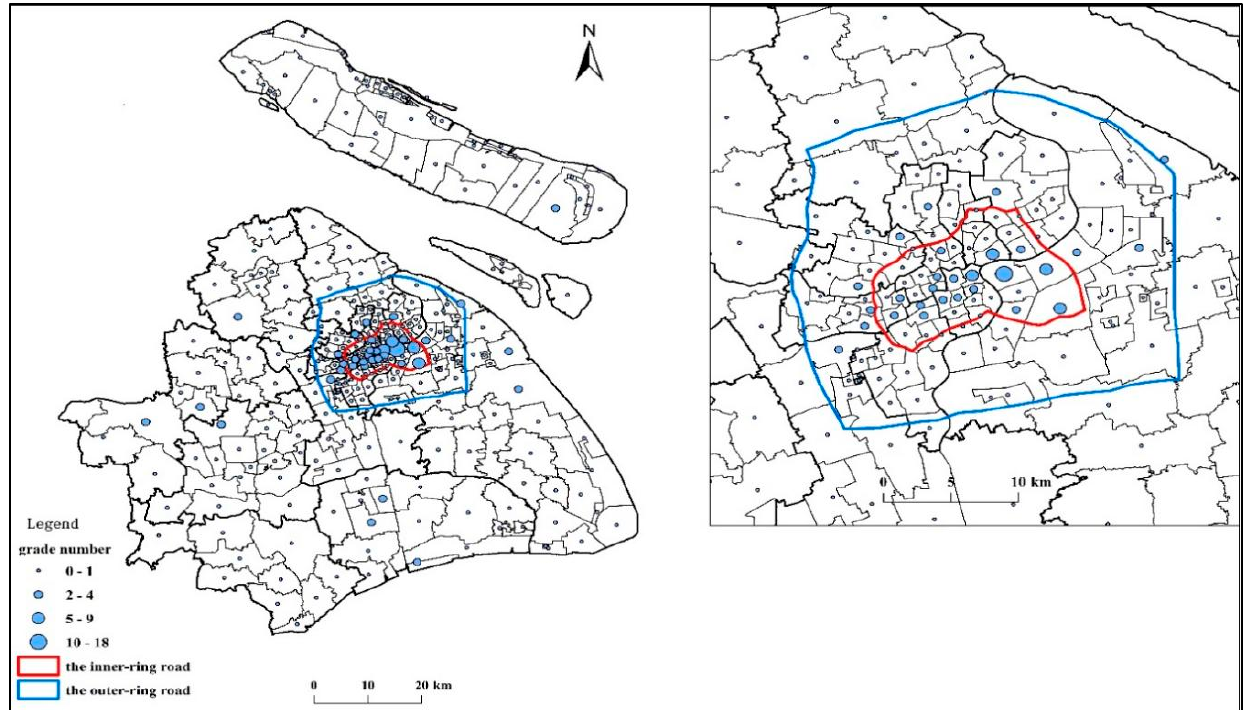
Figure 2. Quantitative description of luxury hotels location in Shanghai metropolitan area (2015). Table 1. The descriptive statistics of model